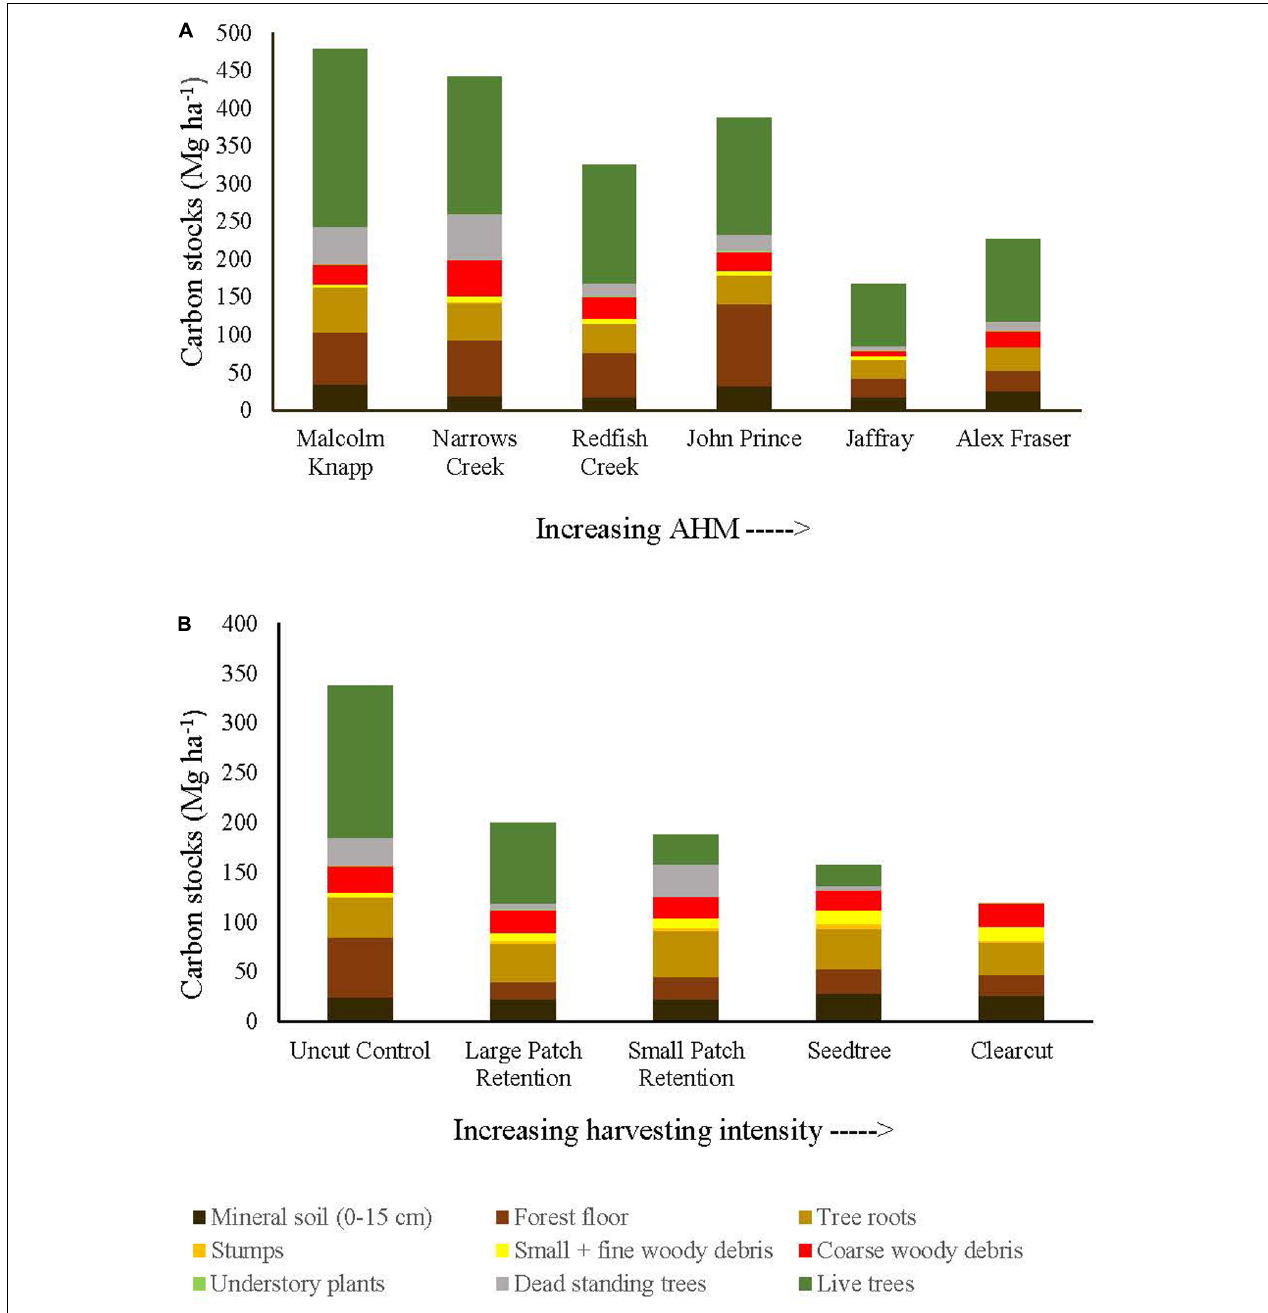
FIGURE 2 | Distribution of carbon stocks among above and belowground pools of mixed Douglas-fir forests ( n = 3 for all locations, except Narrows Creek where n = 1 and Alex Fraser where n = 2). (A) presents mean carbon pools for each location across the climatic aridity gradient (averaged across harvesting intensities). (B) presents mean carbon pools for each harvesting treatment across the harvesting intensity gradient (averaged across locations). The aridity index, AHM, was calculated as [mean annual temperature + 10]/[mean annual precipitation/1000].